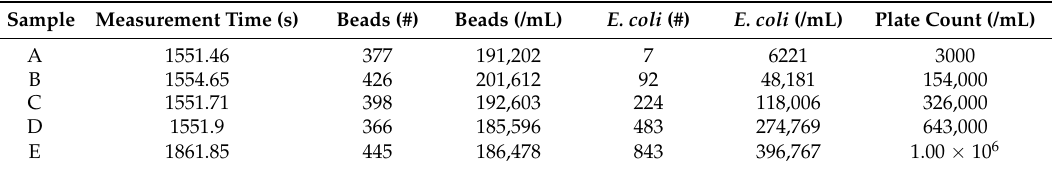
Table 1. Details of the concentration determination experiments, along with the measured transitions and the calculated concentrations by EIS and